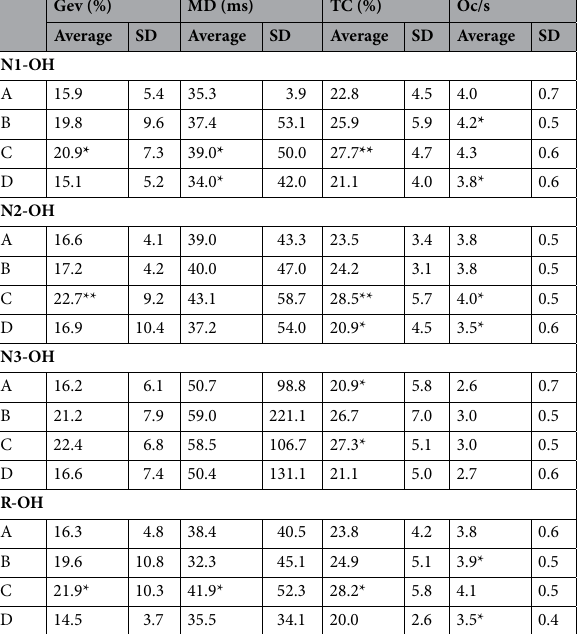
Table 2. Microstate parameters of 4 microstates in OSA-OH patients in 4 sleep stages. The stars indicate the significant difference at each sleep stage between OSA-OH and OSA-withoutOH patients (*P < 0.05, **P <